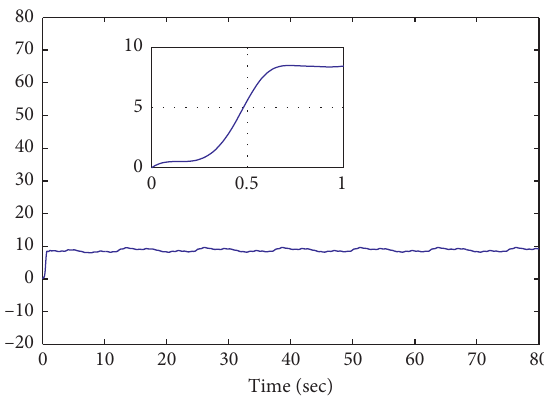
Figure 3: The trajectory of the adaptive law 1.